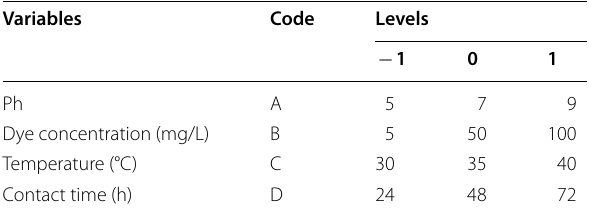
Table 9 Experimental range and levels of input process variables